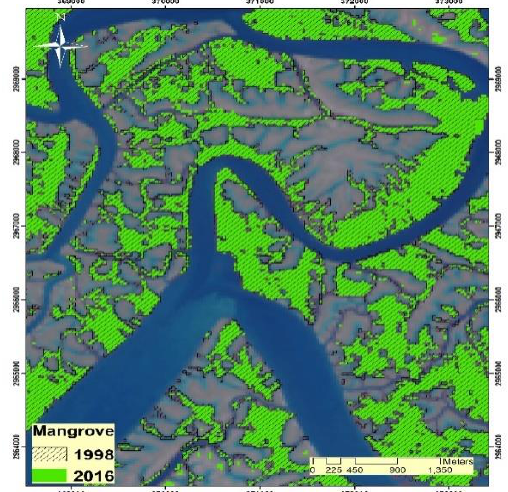
Figure 3. Extent change of Khamir habitat in the period post- 1998